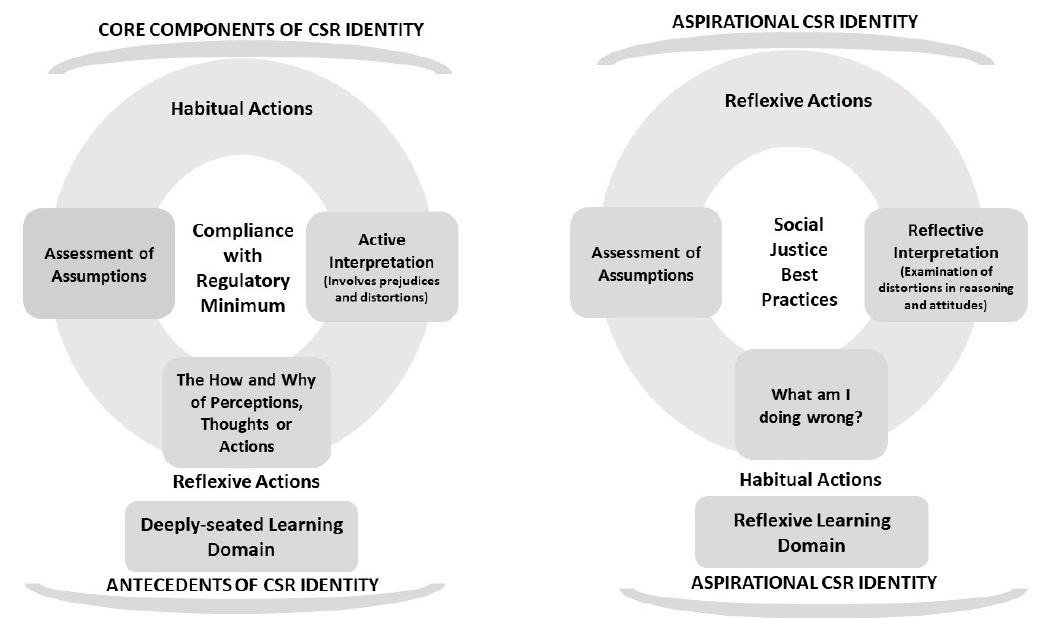
Figure 1. Framework for enabling critical reflexive practices in environmental and social impact assessment (ESIA). Adapted from: